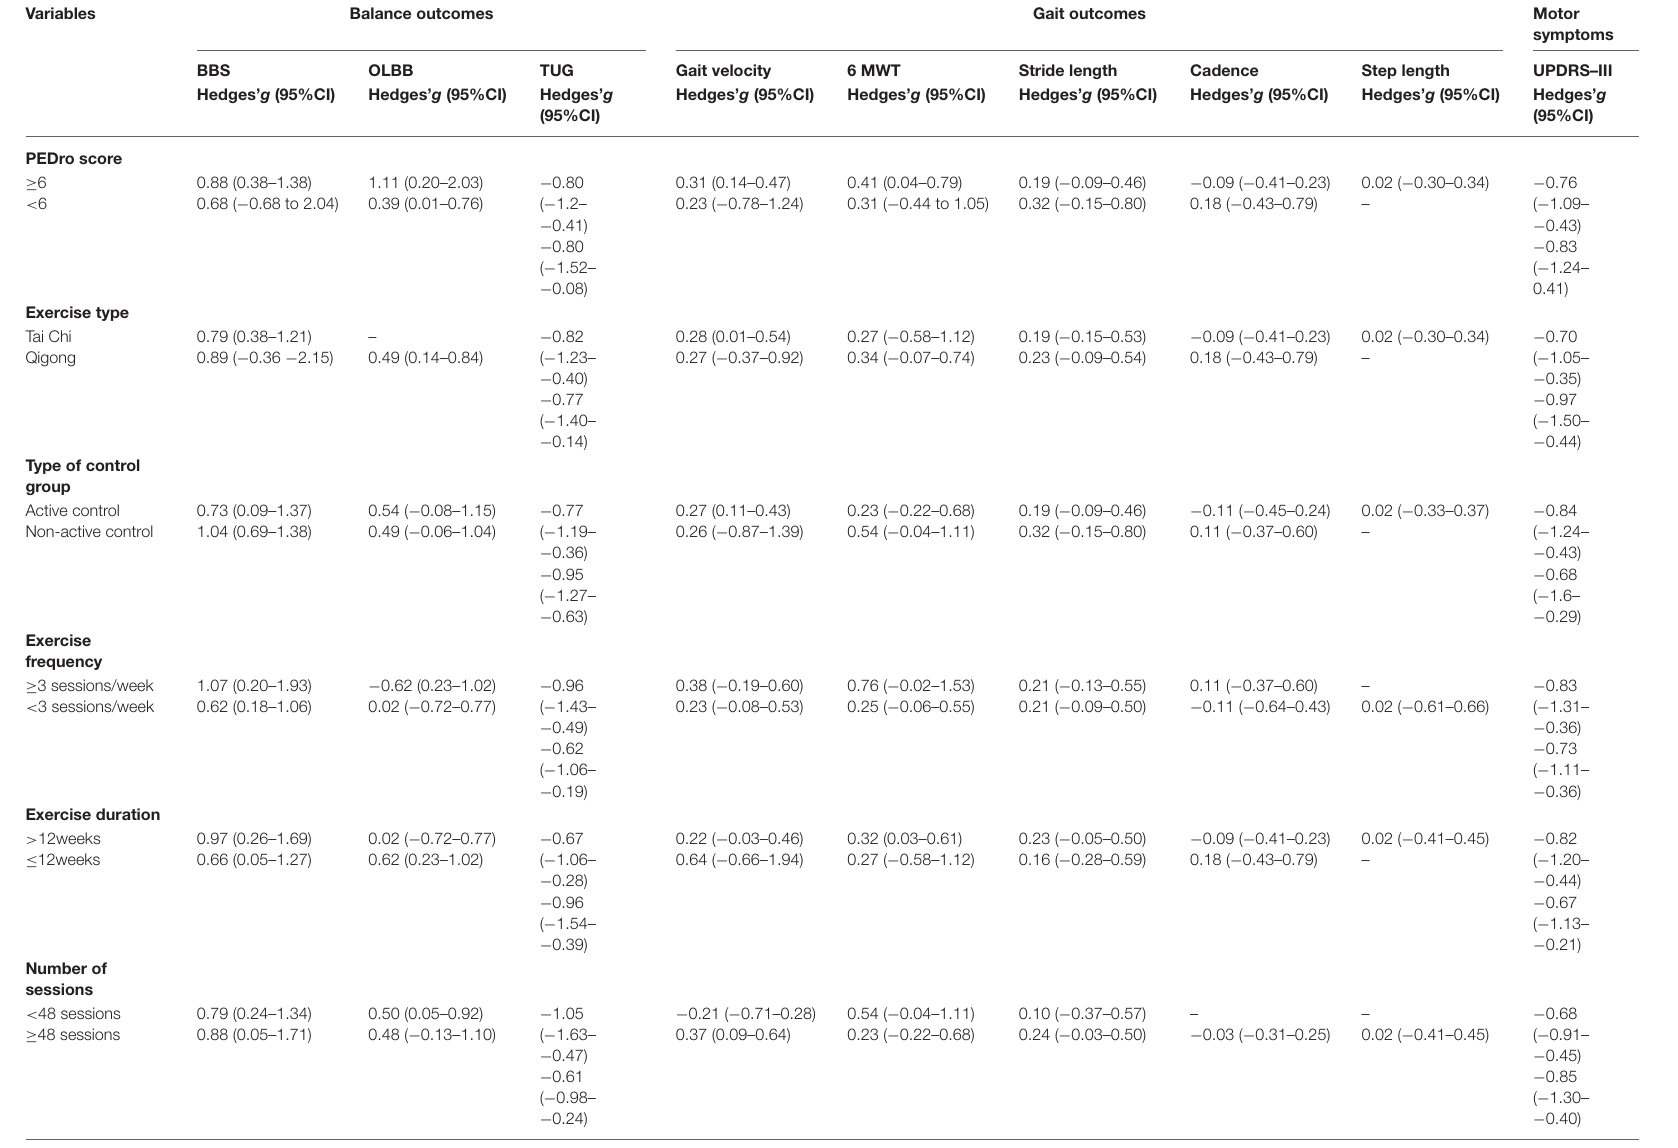
TABLE 4 | Moderator analysis for the effects of TCE on measurement